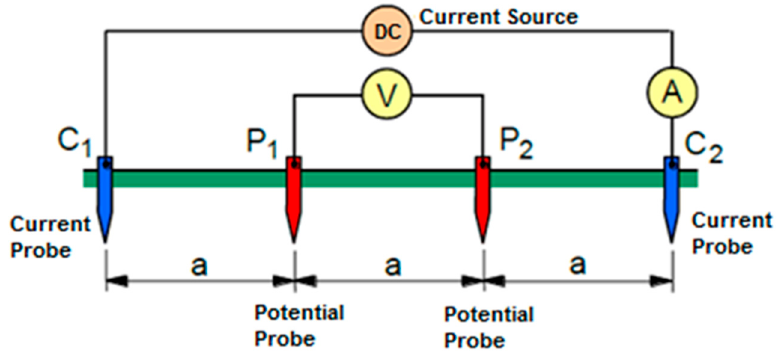
Figure 1. Four-probe Wenner configuration.